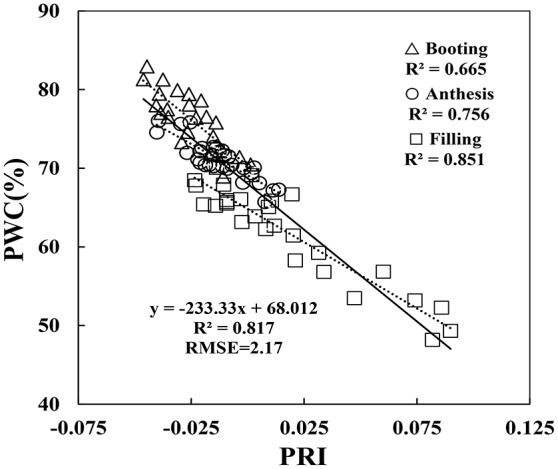
Relationship between PWC and PRI. Data points from Experiments 1–3 (n = 82).